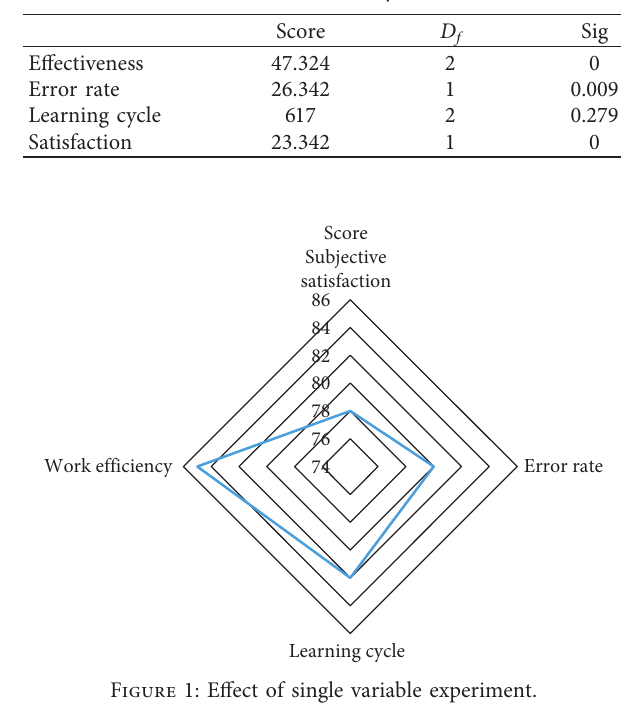
Table 1: Univariate analysis results.